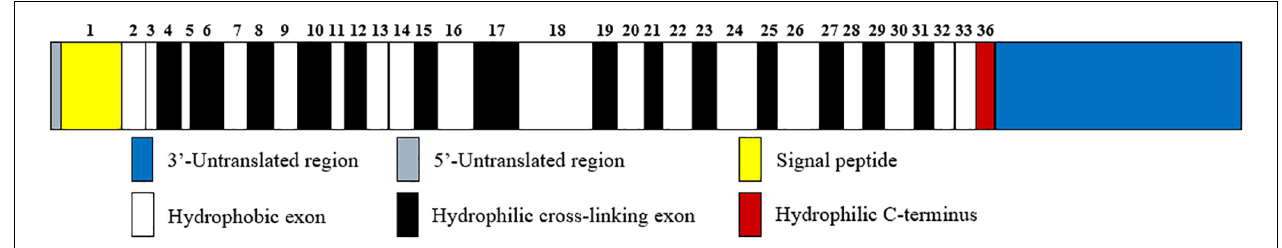
FIGURE 1 | Human tropoelastin domain structure. Tropoelastin contains alternating hydrophobic (white rectangle) and hydrophilic cross-linking domains (black rectangle), and the width of the rectangles corresponds to the length of the domains. The number above the domains represents the sequence of exons that encode them. Among exons, exon 36 encodes a hydrophilic C-terminus (red rectangle) in addition to a 3 (cid:48) -untranslated region (blue